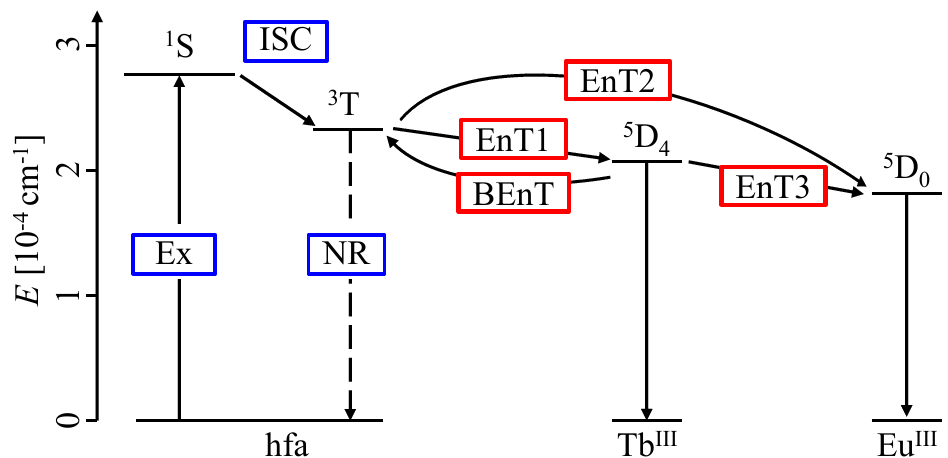
Figure 2. Energy transfer diagram of the chameleon luminophore (Ex: excitation, ISC: intersystem crossing, NR: nonradiative process, EnT: energy transfer, BEnT: back energy transfer)